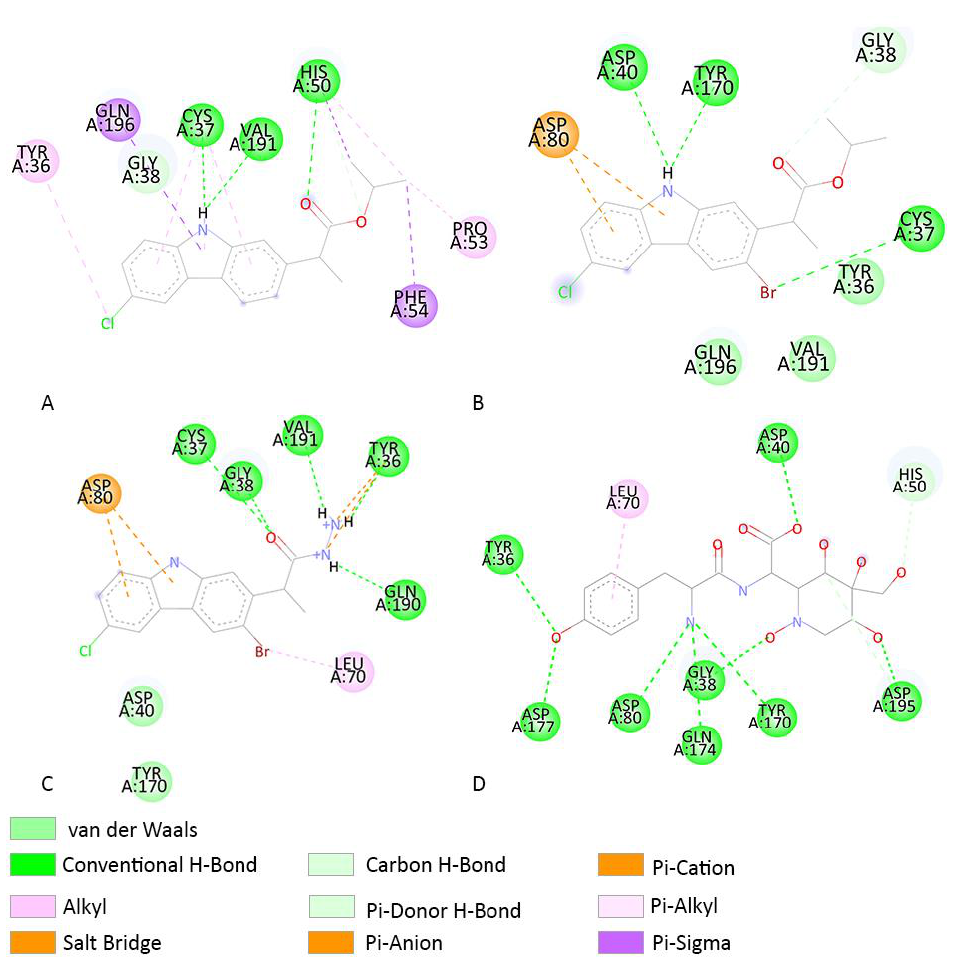
Figure 11. Predicted interactions between compounds 2 ( left side ), compound 3 ( right side ) and the PBP3 receptor. Images were obtained using Discovery Studio Visualizer [33].